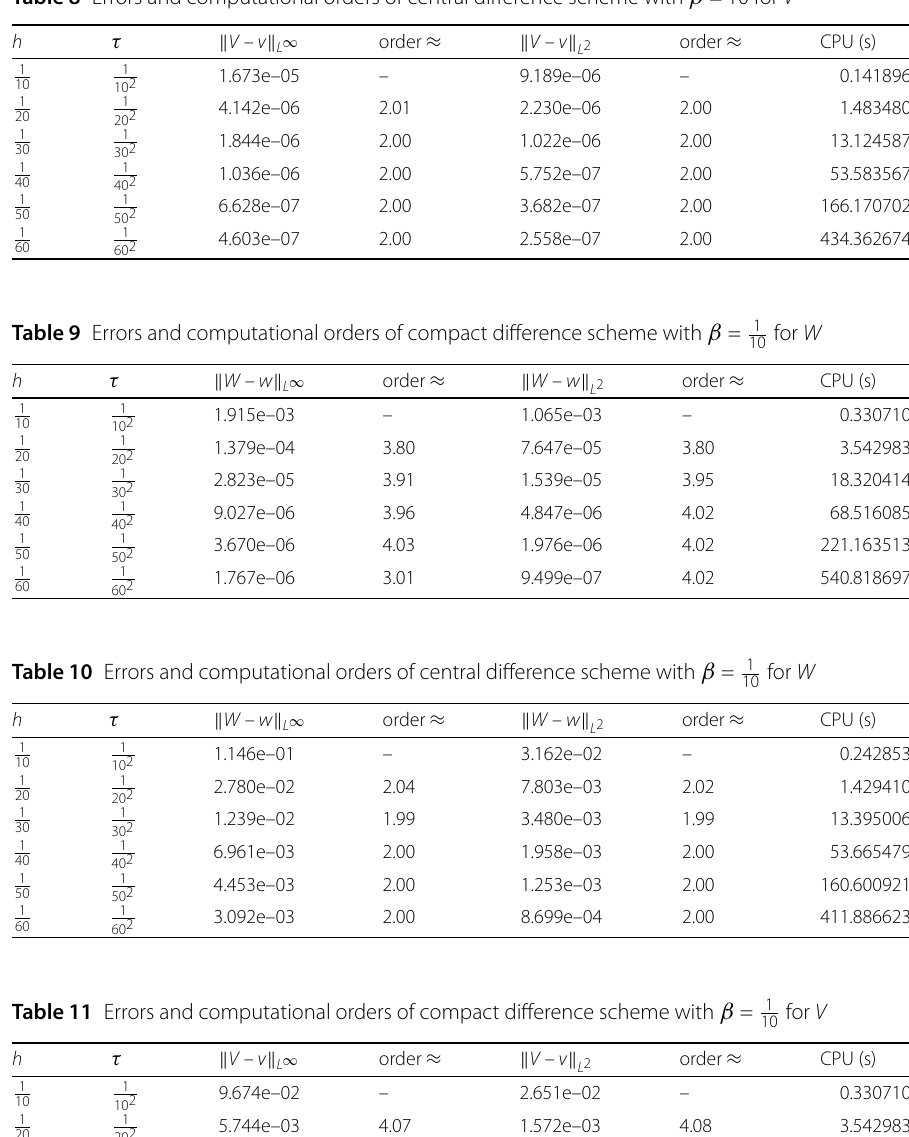
Table 11 Errors and computational orders of compact difference scheme with β = 1